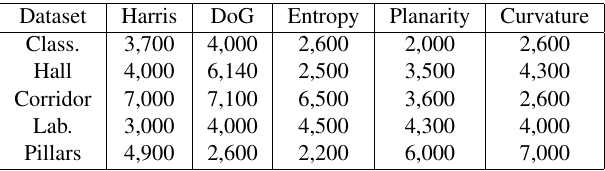
Table 2. Mean number of keypoints